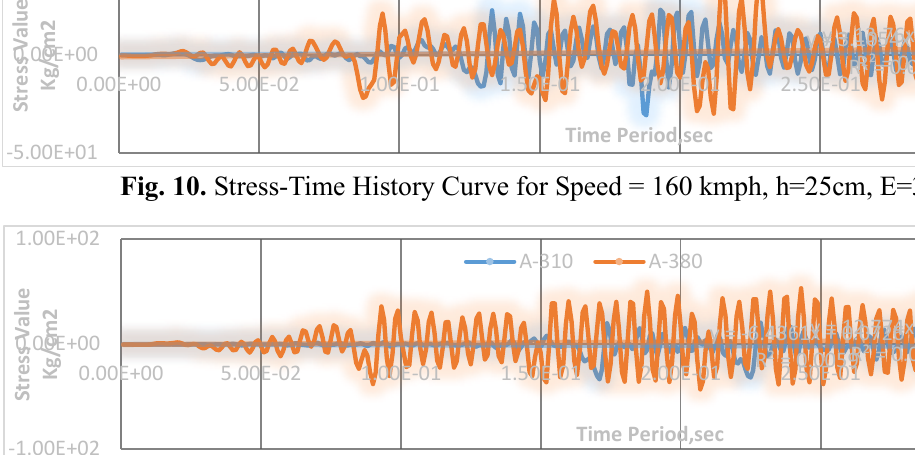
Fig. 11. Stress-Time History Curve for Speed = 160 kmph, h=25cm,